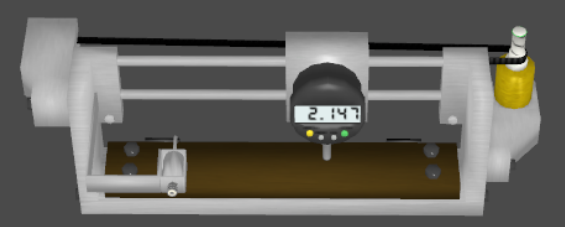
Figure 6. Reproduction of a remote system for flatness evaluation.